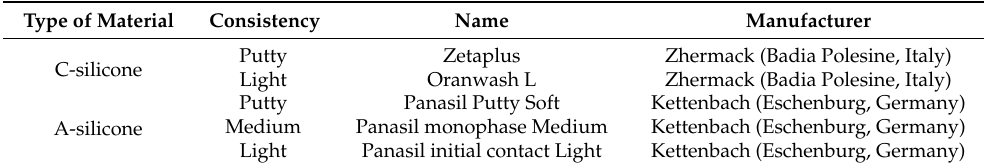
Table 1. Description of dental impression materials used in the